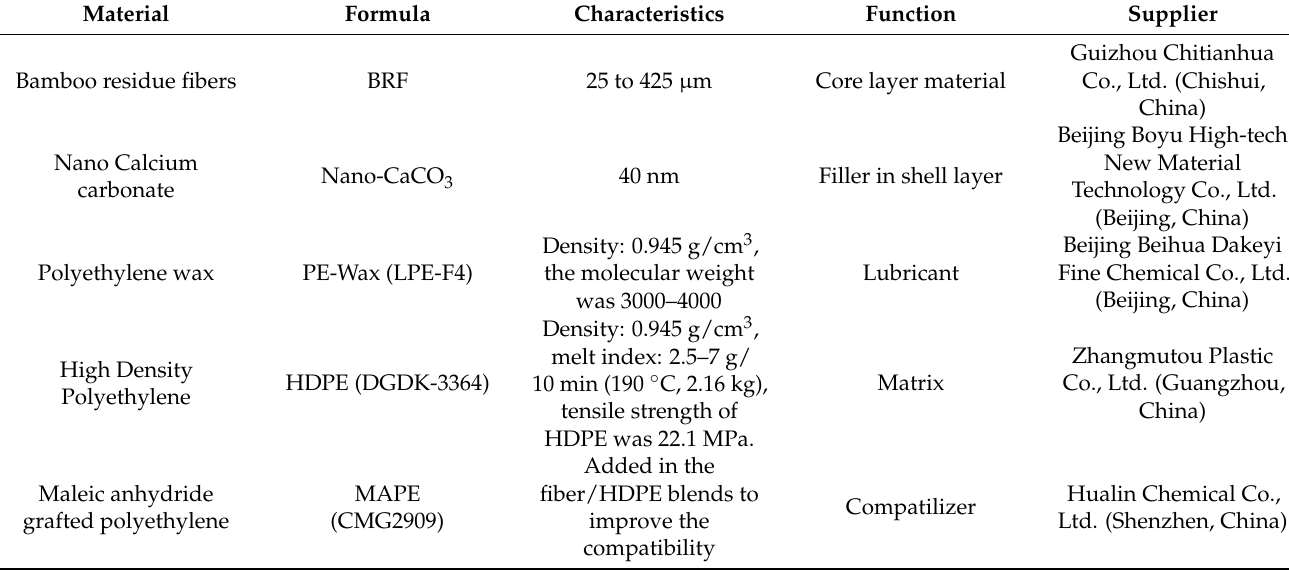
Table 1. Characteristics of raw materials.